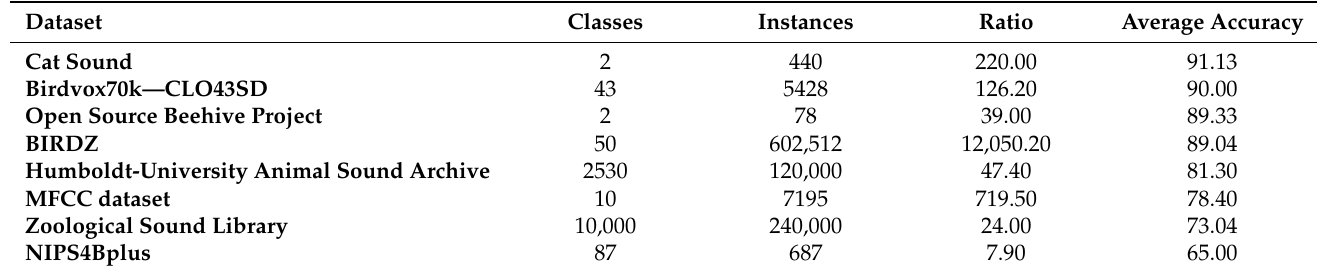
Table 4. Bioacoustics dataset size and classification